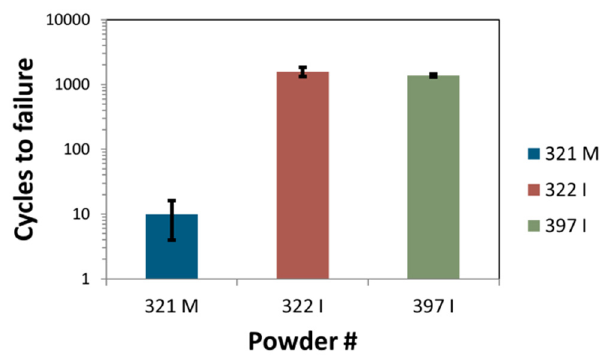
Figure 9. Cycles to failure of burner rig test samples sprayed with LZ powders 321 M, 322 I, and 397 I processed by TriplexPro™-210 torch at low power (22 kW) and with Ar–He plasma gas mixture; note the logarithmic scale.